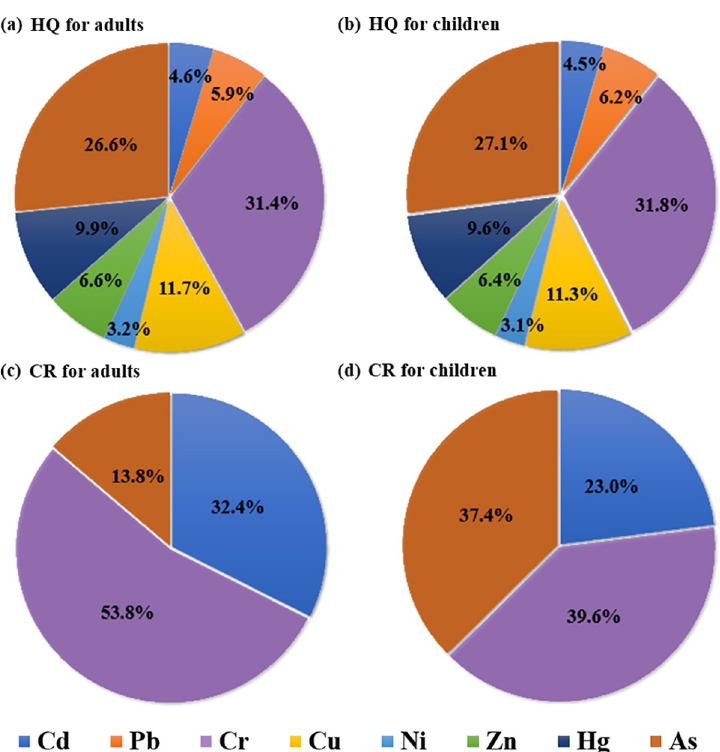
Fig 5. Contribution of non-carcinogenic and carcinogenic caused by each element to THI and TCR. HQ for (a) adults and (b) children, CR for (c) adults and (d) children.